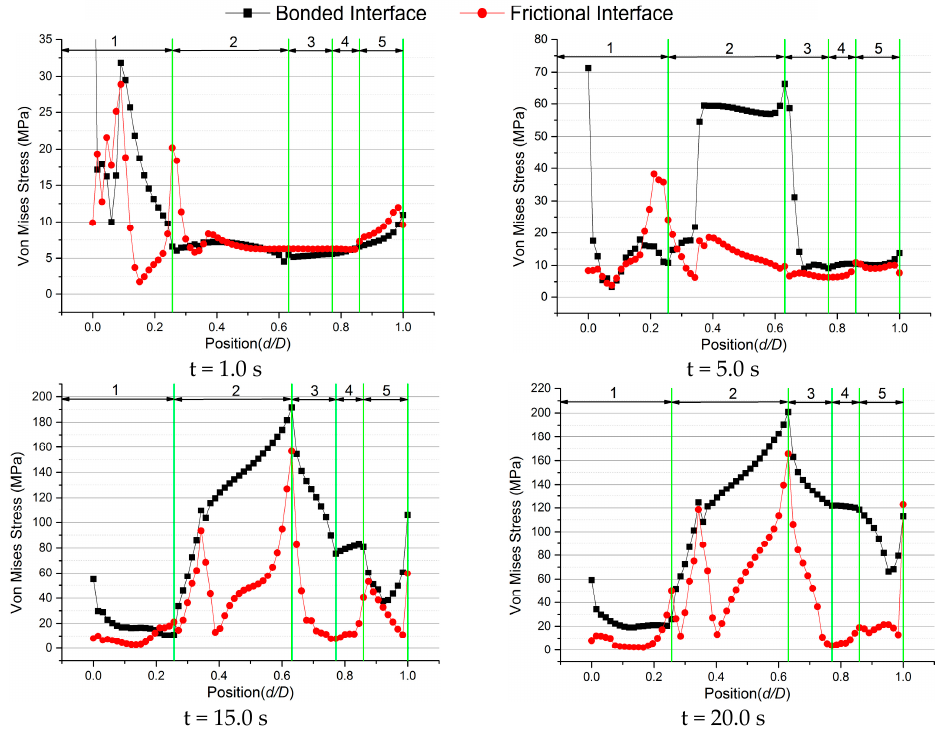
Figure 11. Von Mises stress variation curves of the passageway for the two different types of interface treatments.